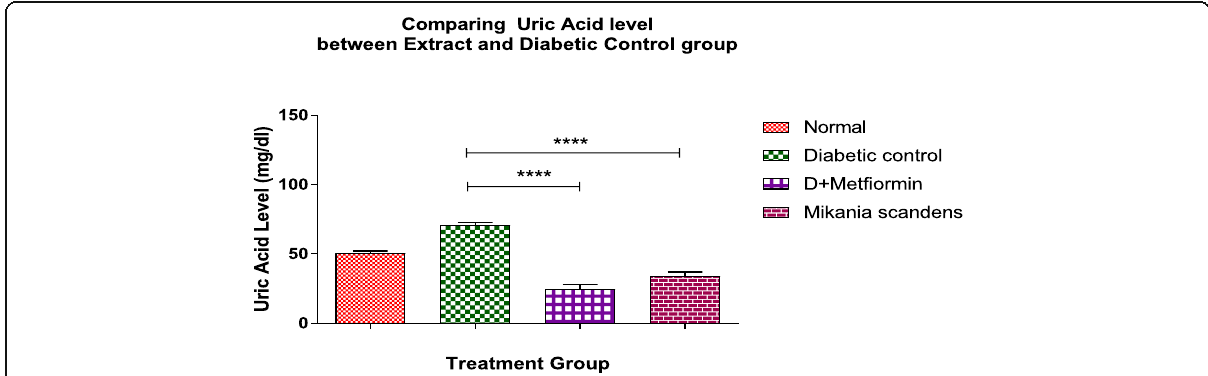
Fig. 4 Comparing the serum uric acid level among the diabetic control, metformin HCL and Mikania scandens animal groups. Significantly different ( p < 0.05) from the diabetic control. Data were analyzed by one way ANOVA followed by scheffe ’ s post-hoc test